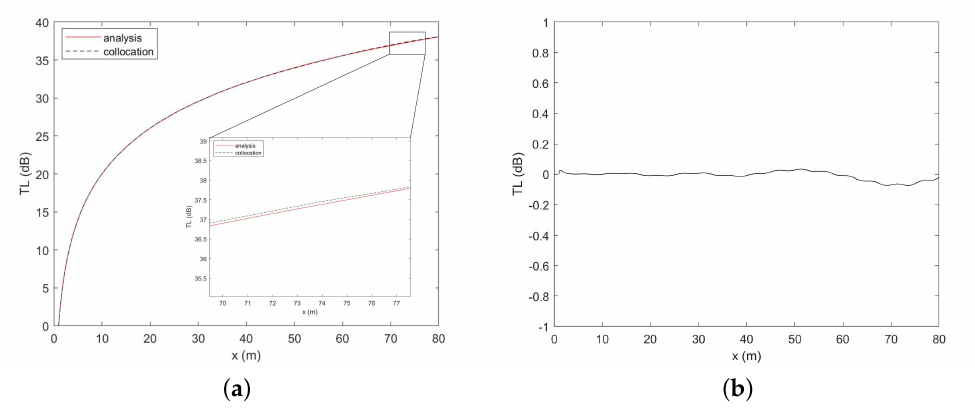
Figure 3. The TL curve calculated by the analytical solution (red solid line) and Chebyshev– collocation spectral method (black dashed line) at the depth of the sound source ( a ); the error between the numerical solution and the analytical solution ( b